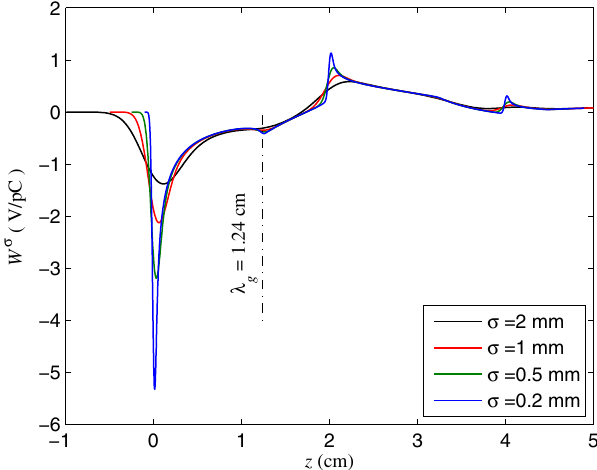
FIG. 6. Wake potentials for rectangular profile cavity with